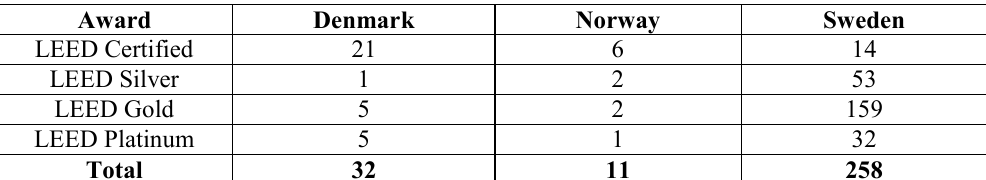
Table 1. LEED Projects (Developed by authors)